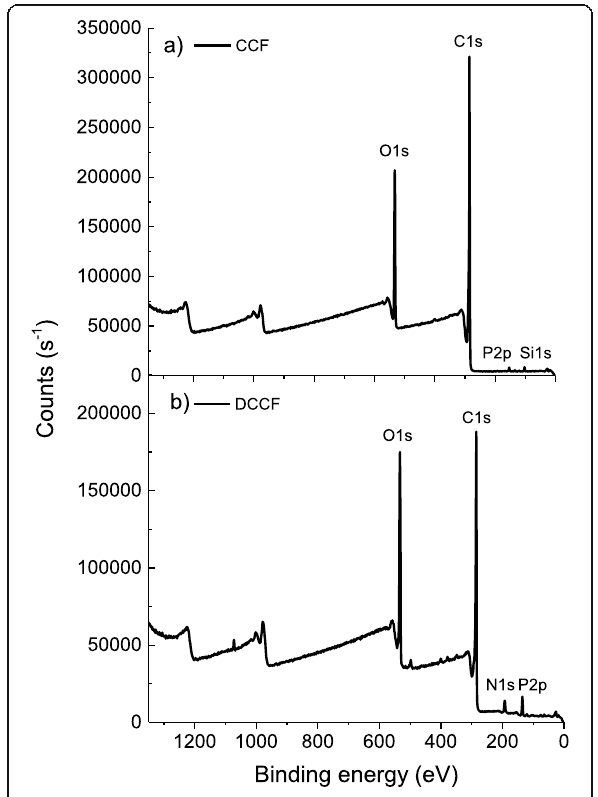
Fig. 3 Survey scan plots of a CCF and b DCCF adsorbents